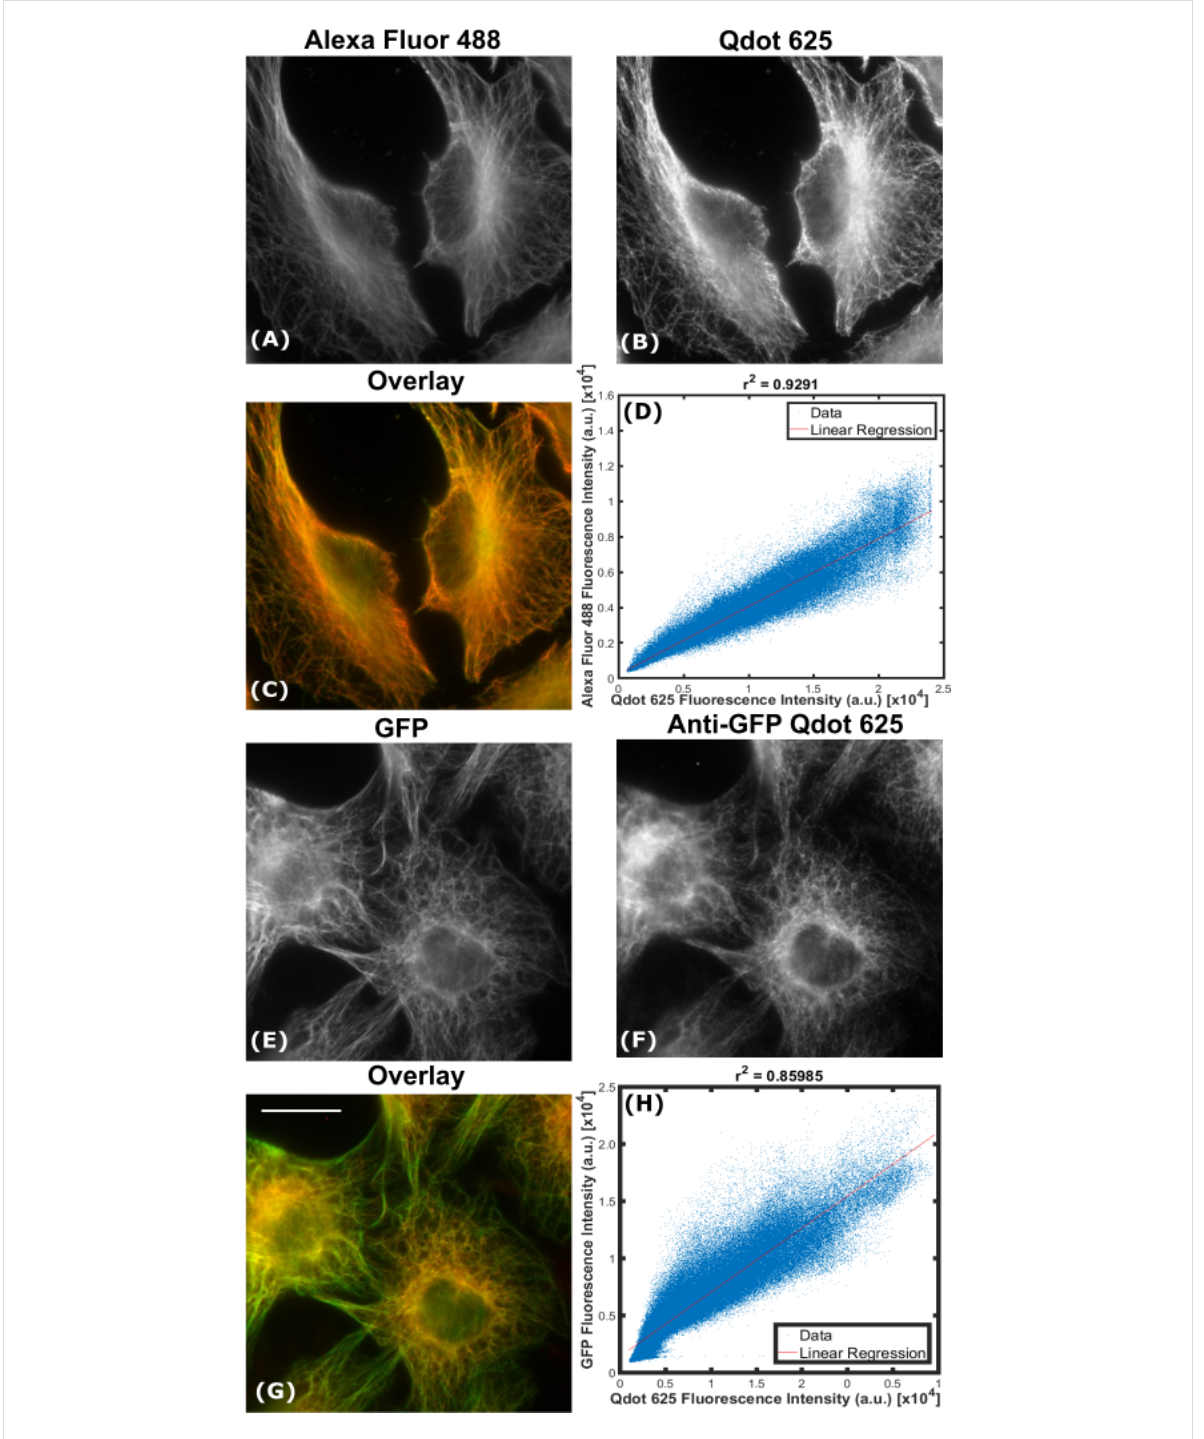
Figure 3: Specific labelling of tubulin with Qdots. Methanol-fixed HeLa cells were labelled indirectly with a primary anti-tubulin antibody, green Alexa Fluor 488 (A), and red Qdot 625 (B), to produce an overlaid wide-field image (C). As a measure of co-localisation between Alexa Fluor 488 and Qdot 625, fluorescence intensities of the overlaid wide-field image (C) were analysed using a custom-written Matlab code to produce a correlation scatter plot (D). Pearson’s correlation coefficient ( r 2 ) of 0.93 indicates very high correlation. The average Manders coefficient of Alexa Fluor 488 overlapping with Qdot 625 (M1) was 0.99 (SD = 0.007, N = 3) and the average Manders coefficient of Qdot 625 overlapping with Alexa Fluor 488 (M2) was 0.99 (SD = 0.005, N = 3, as determined using JACoP. Paraformaldehyde fixed TC7 cells, expressing tubulin-GFP (E), were also labelled directly with an anti-GFP Qdot 625 conjugate (F) to produce an overlaid wide-field image (G,) and a corresponding correlation scatter plot (H); with a Pearson’s corre- lation coefficient ( r 2 ) of 0.86. Scale bar is 20 μ